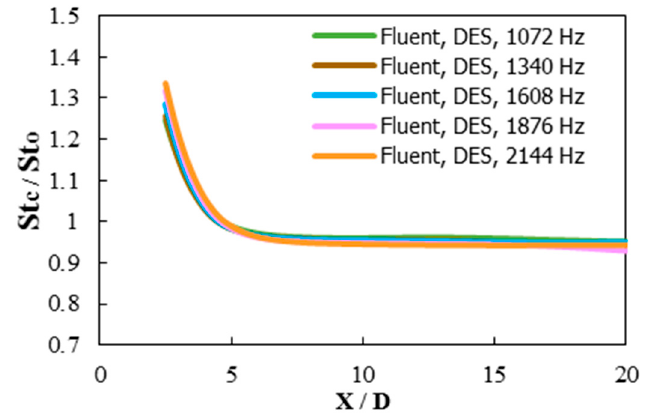
Figure 31. The centerline Stanton number ratio obtained using the DES Realizable k - ε model for M = 0.5 for the 1072, 1340, 1608, 1876, and 2144 Hz oscillations.